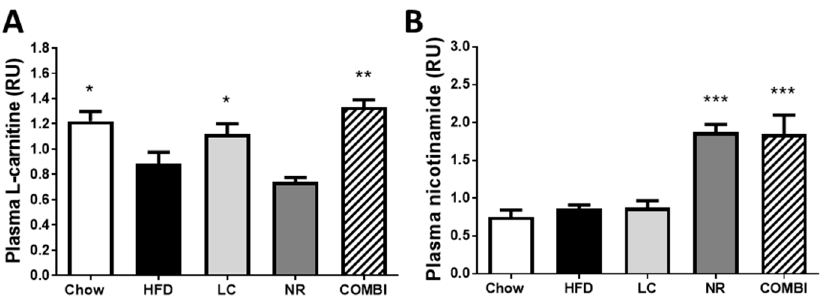
Figure 1. Dietary L-carnitine (LC), nicotinamide riboside (NR) or both (COMBI) supplementation to a high-fat diet (HFD) increased the plasma levels of L-carnitine and nicotinamide after 21 weeks of treatment, indicating effective delivery via the diet. LC-MS was used to measure plasma levels of ( A ) L-carnitine and ( B ) nicotinamide. Data are presented in relative units (RU) as mean ± SEM, * p < 0.05 or ** p < 0.01 or *** p < 0.001 compared to the HFD control group.